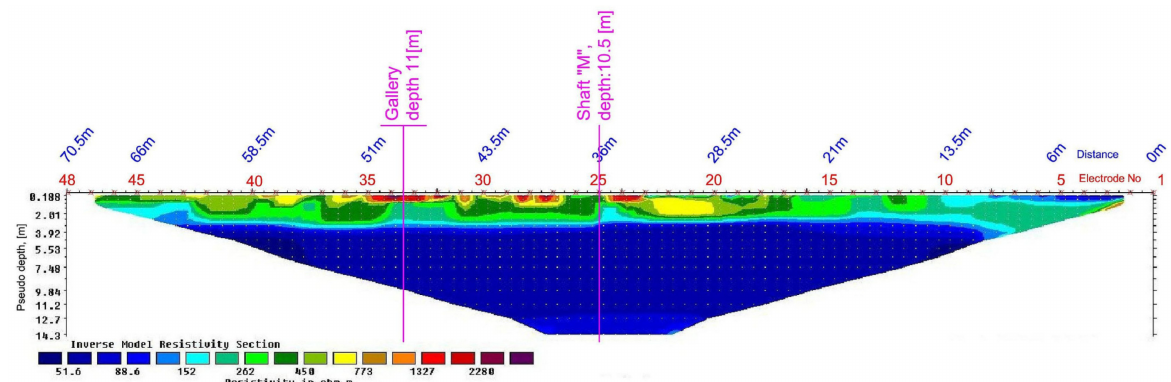
Figure 13. ERT profile obtained on the line with the Wenner α electrode array.